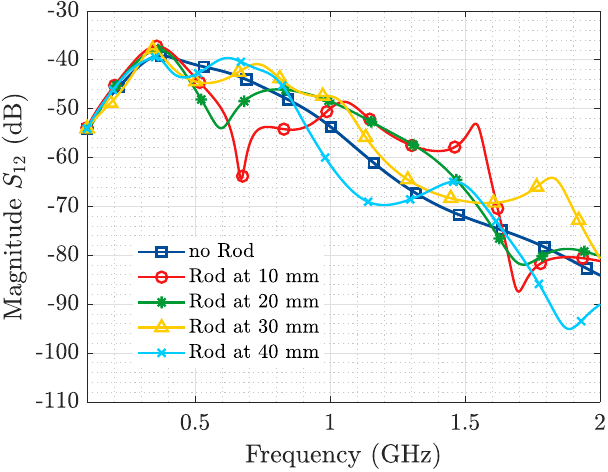
Figure 6. Metallic Rod Detection. Simulation S 12